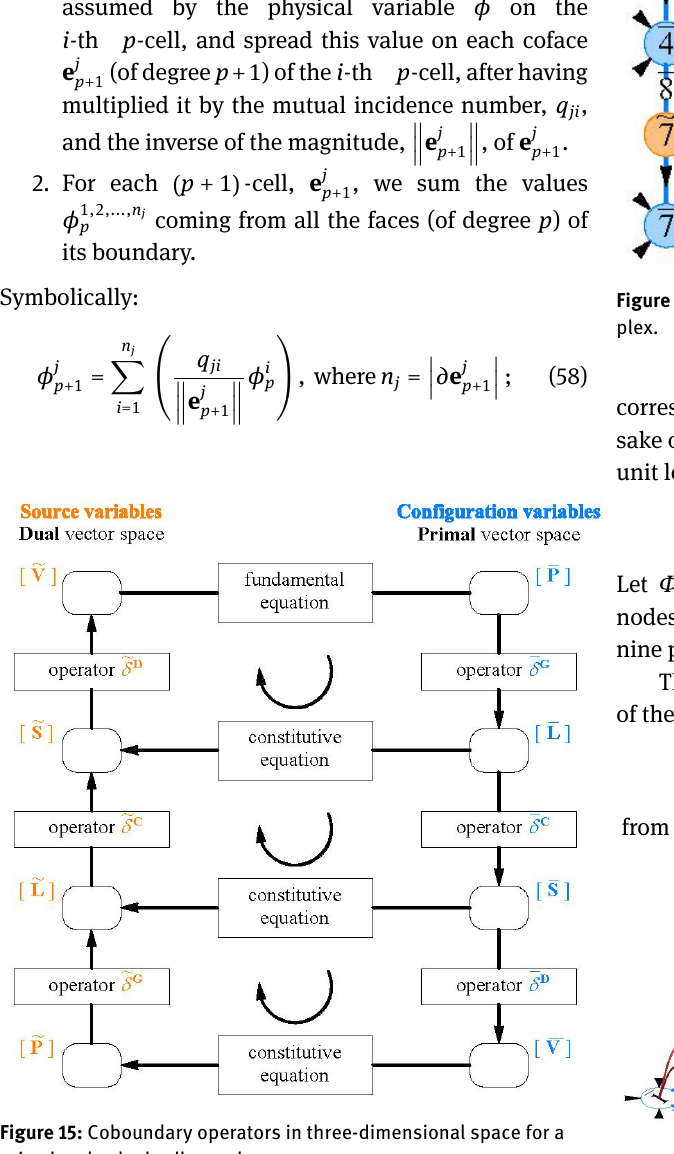
Figure 15: Coboundary operators in three-dimensional space for a primal and a dual cell complex.